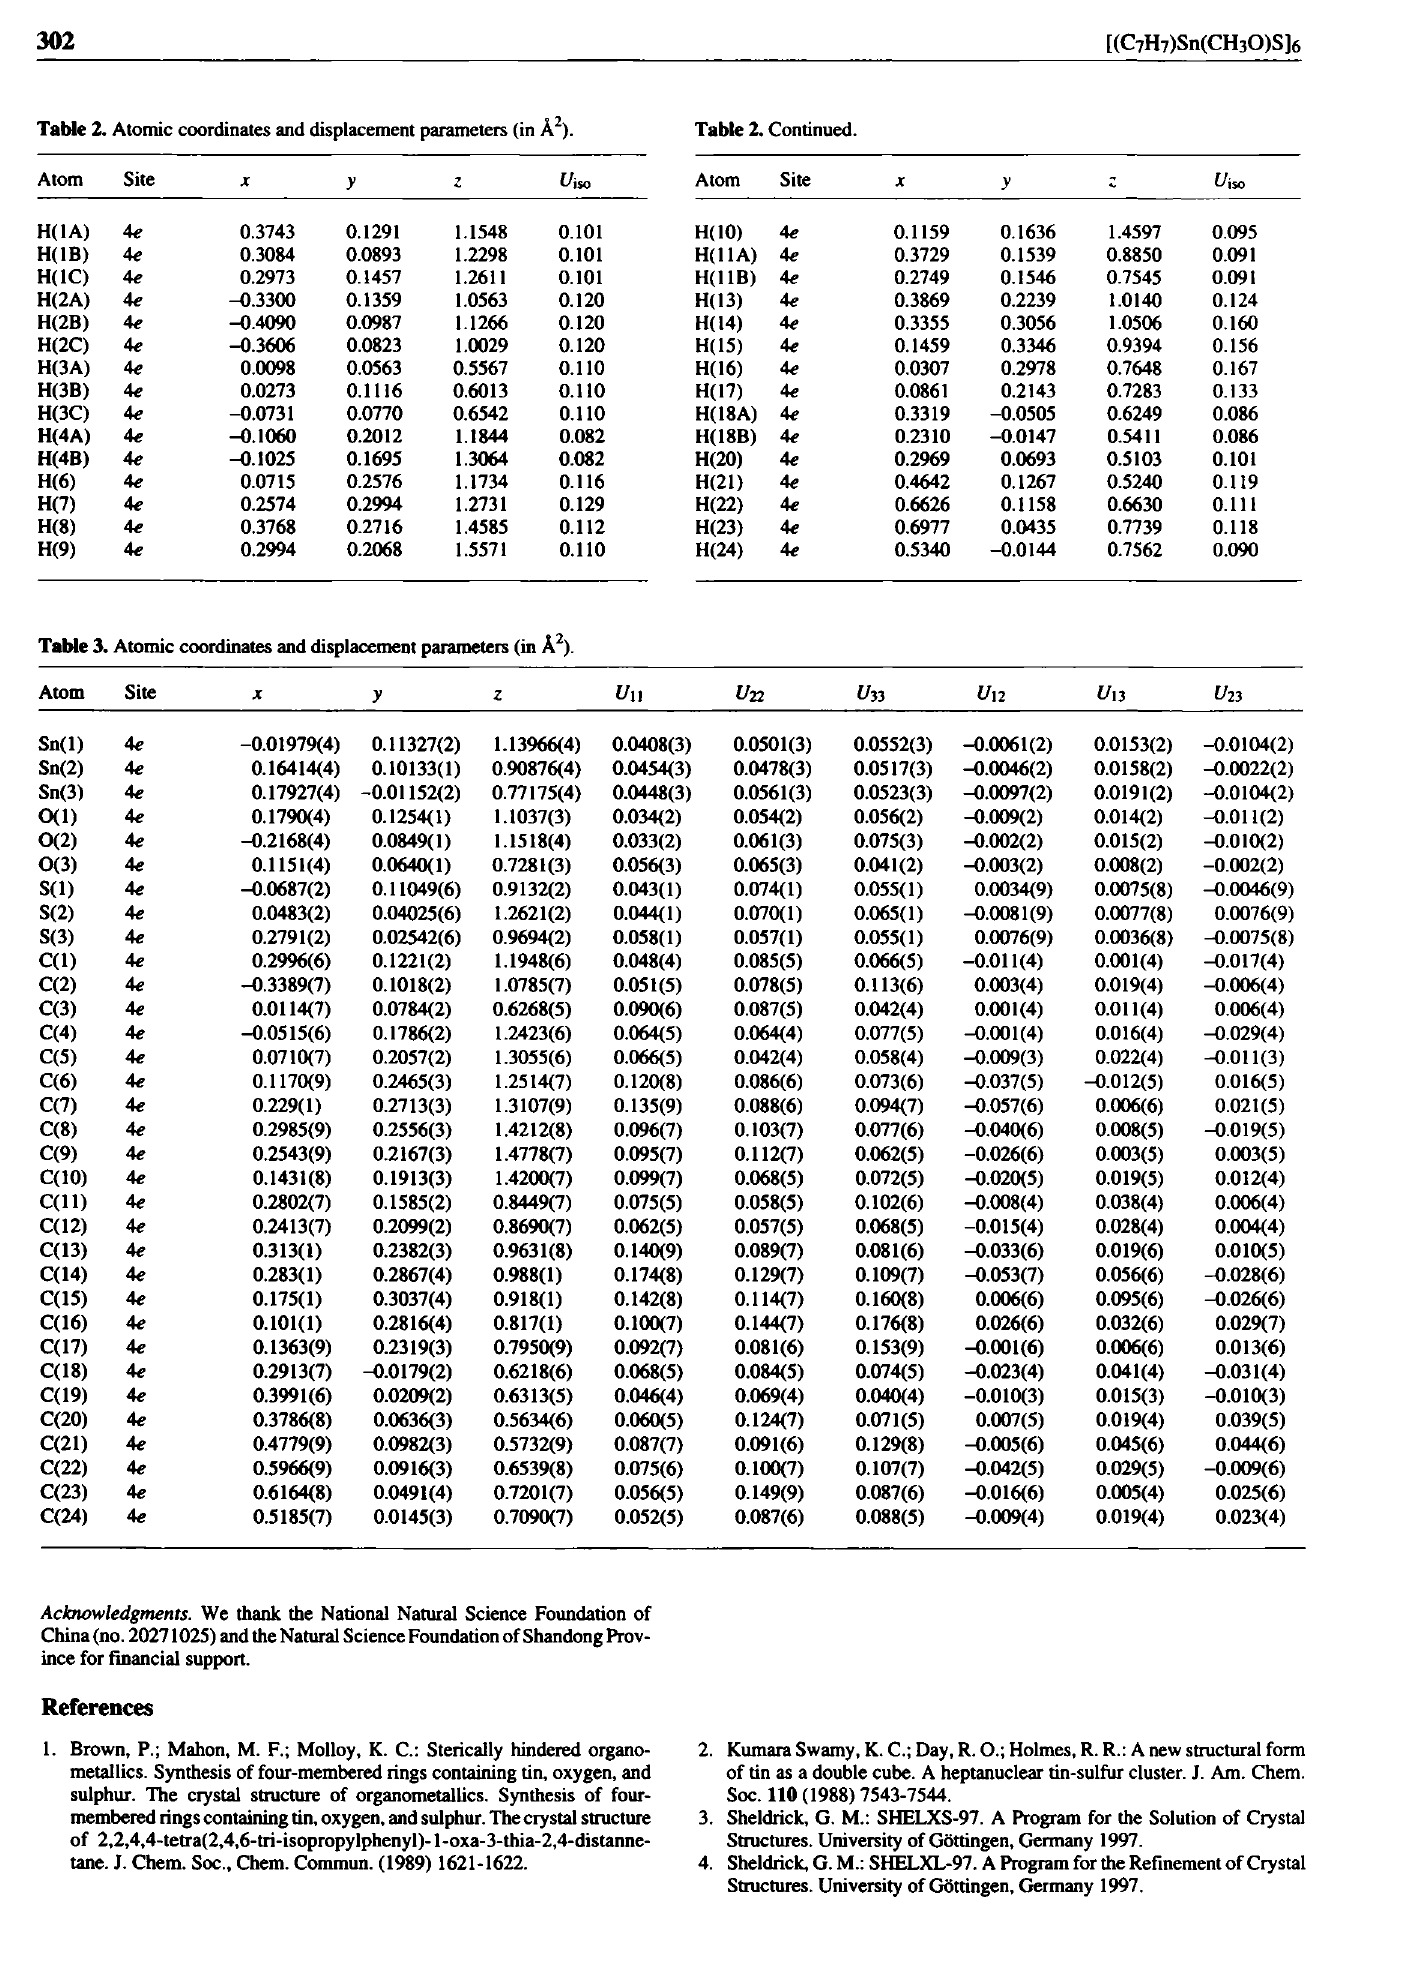
Table 2. Atomic coordinates and displacement parameters (in À 2 ).